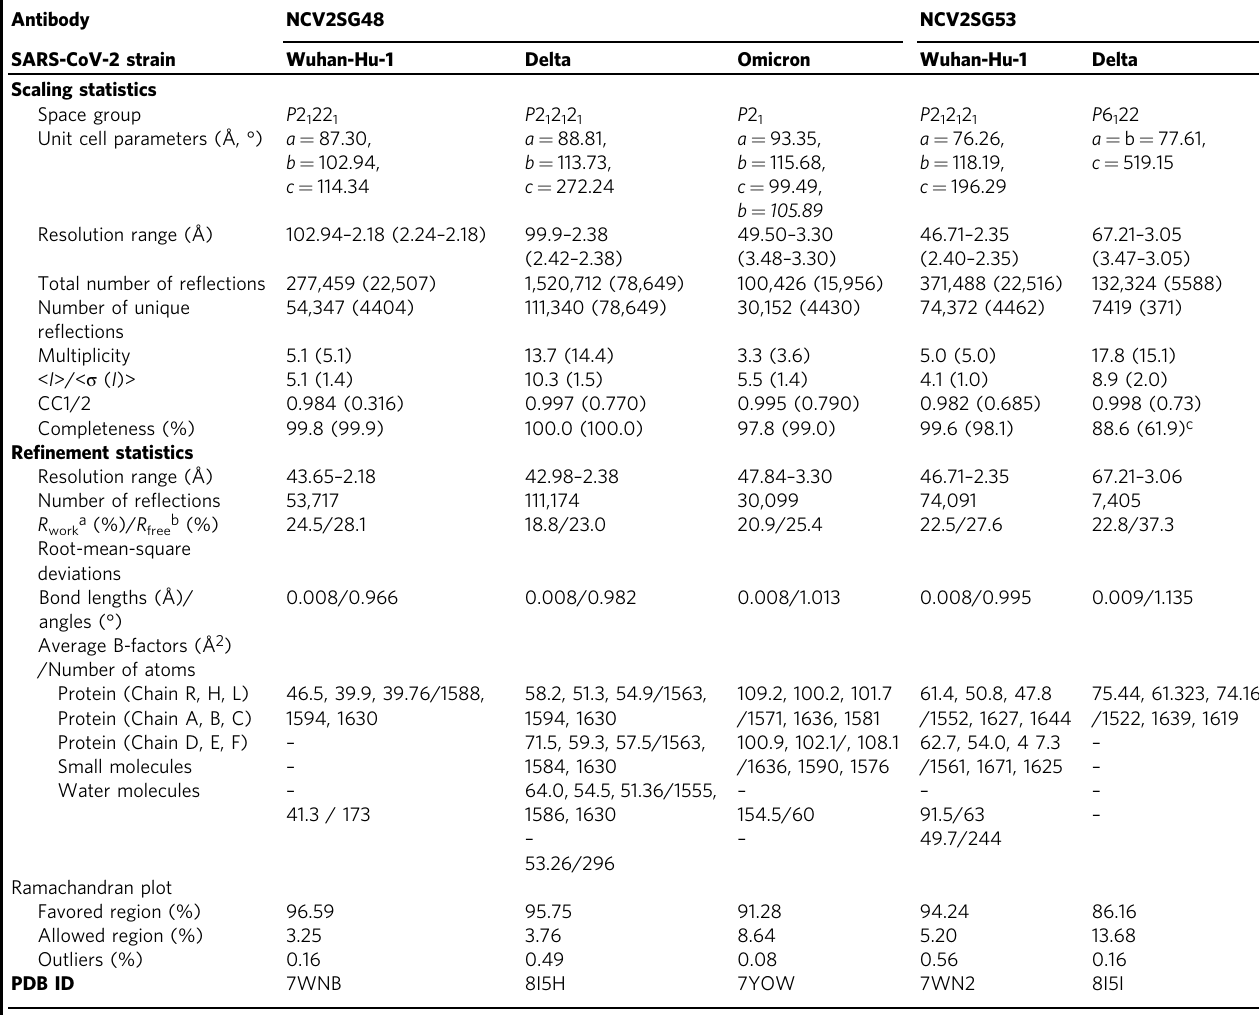
Table 1 Data collection and re fi nement statistics Values in parentheses indicate the highest-resolution shell.